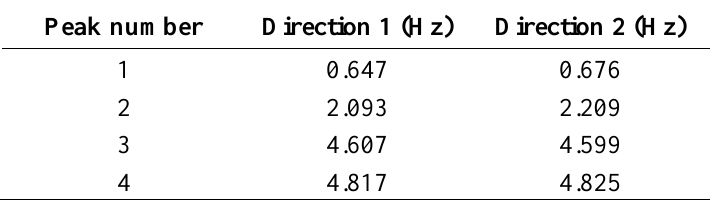
Table 1. Experimental natural frequencies of the